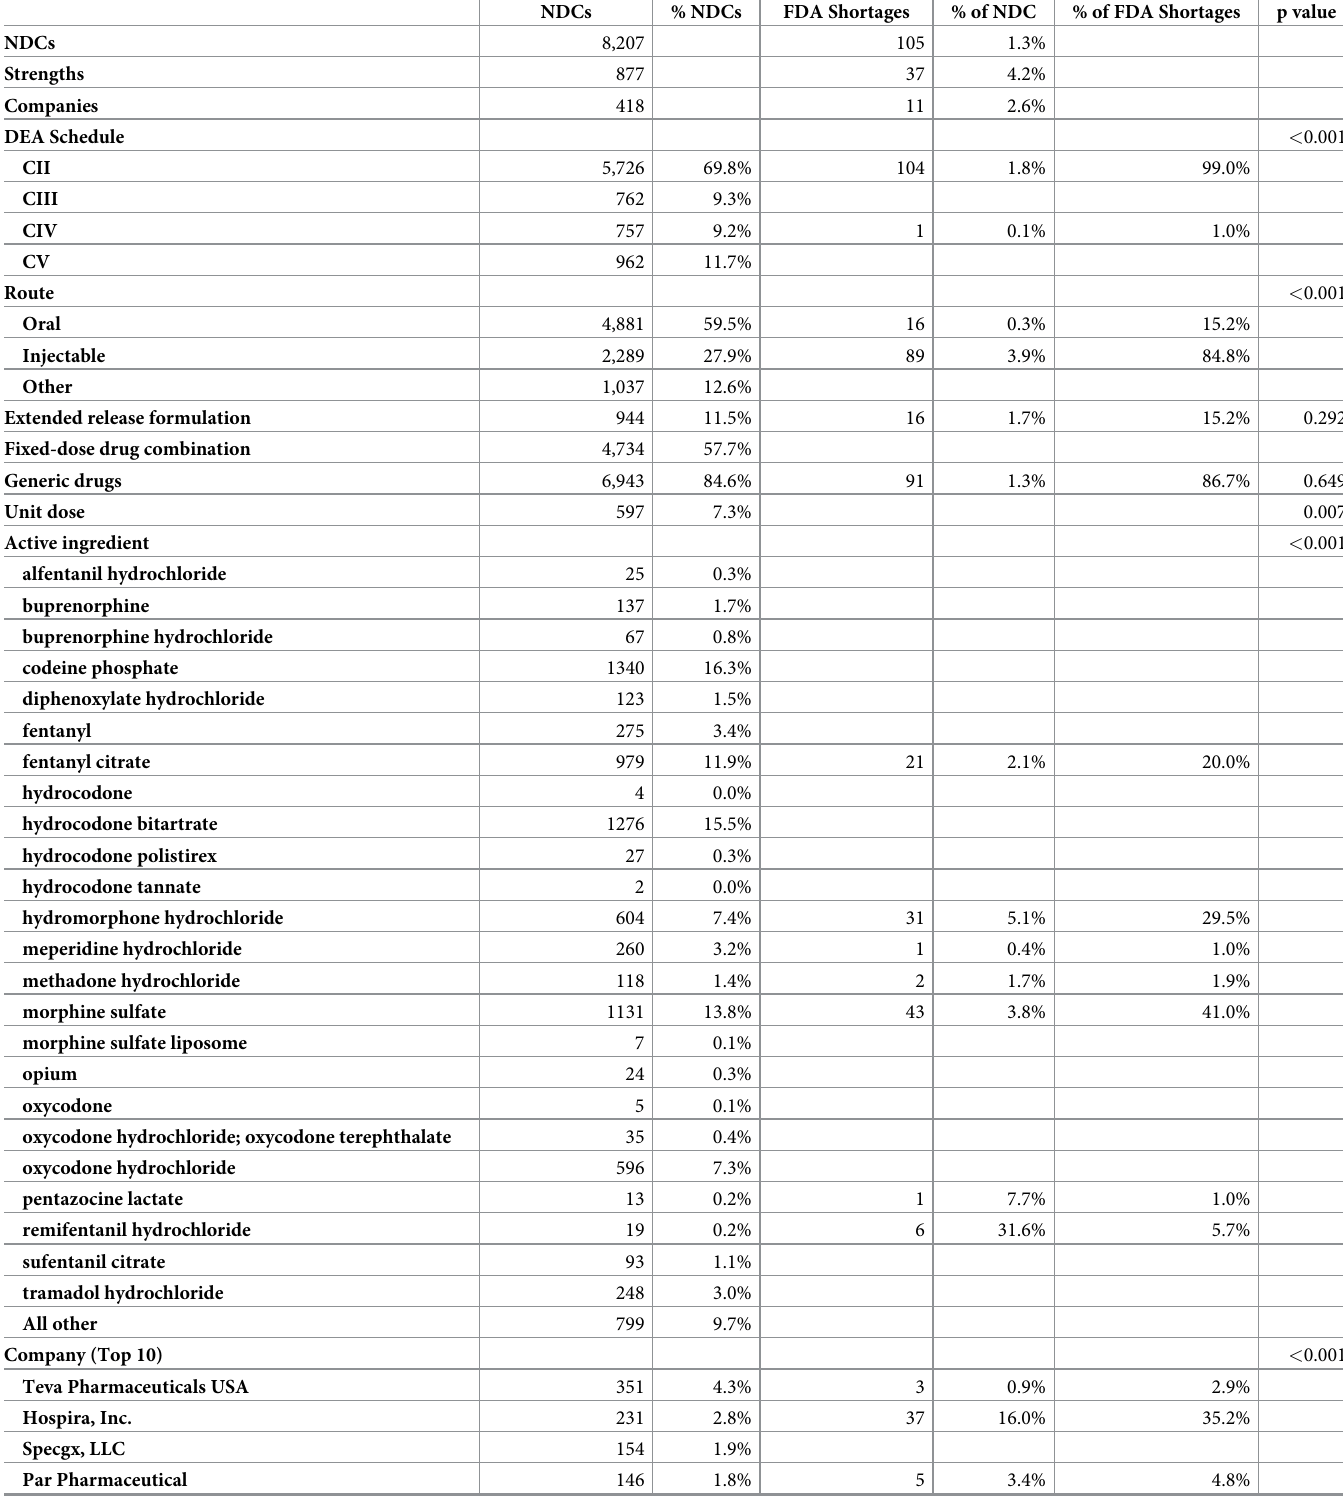
Table 1. FDA approved opioid NDCs and shortages,